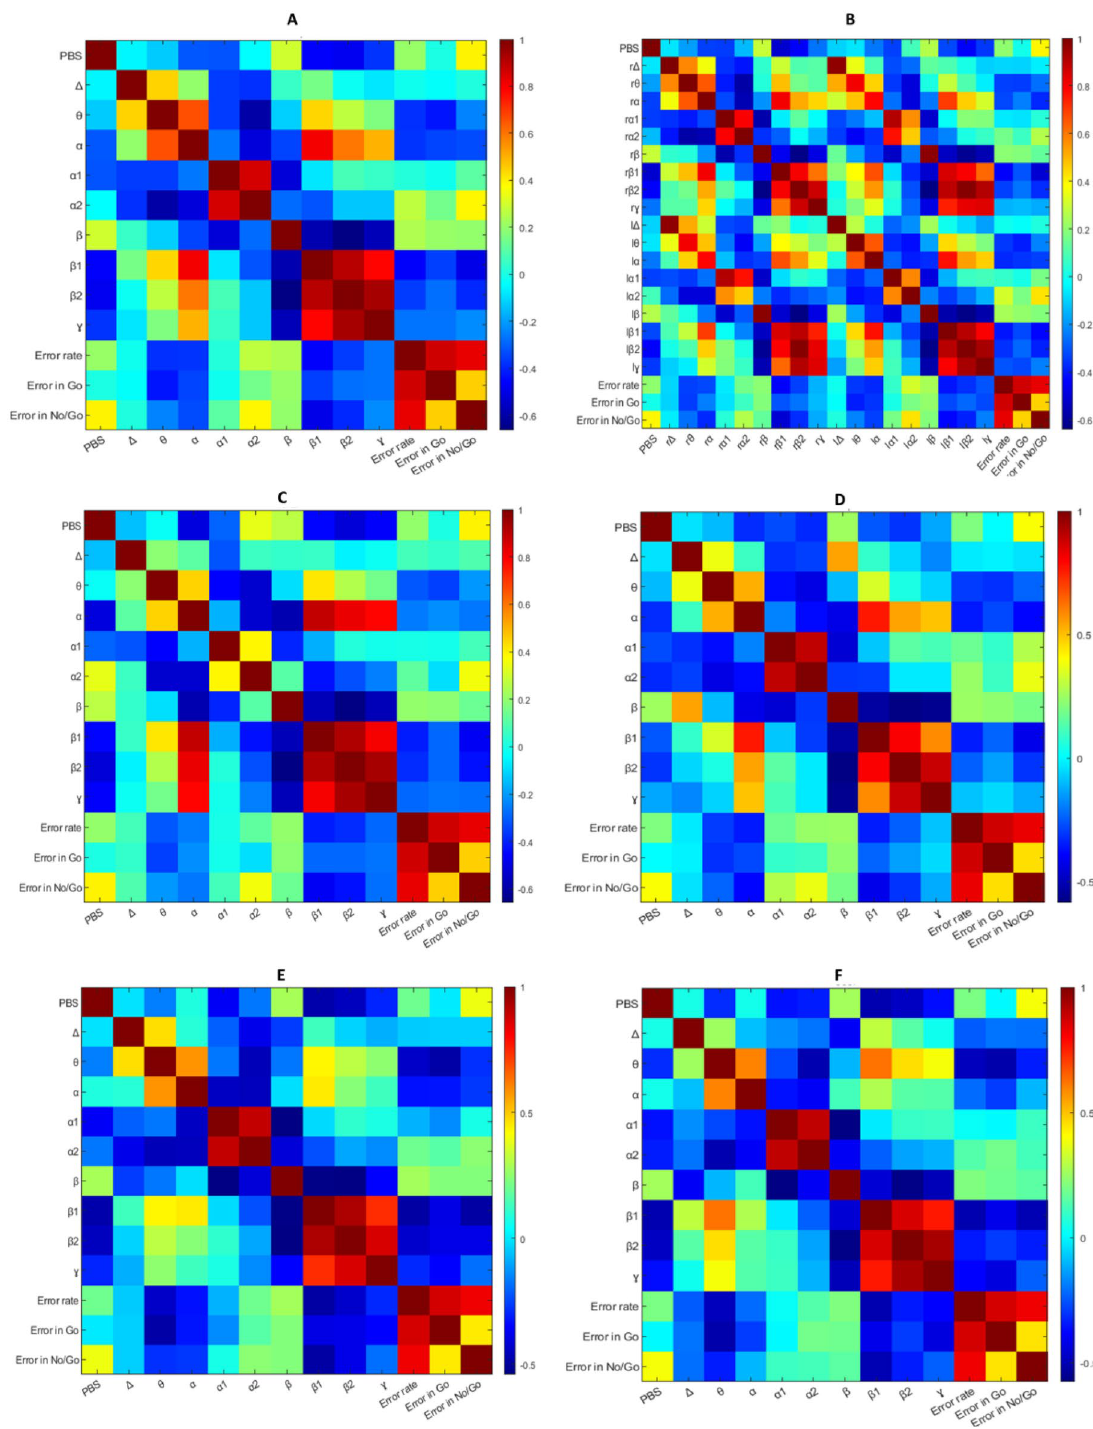
Figure 7. The heatmap results of pairwise correlation matrices of the frequency bands, RPBS, and Go-No/Go task in ( A ) whole brain, ( B ) right and left hemispheres ( C ) frontal lobe ( D ) temporal lobe ( E ) parietal lobe, and ( F ) occipital lobe. RPBS paranormal beliefs scale, Δ Delta band, θ Theta band, α Alpha band, α1 Alpha1 band, α2 Alpha2 band, β Beta band, β1 Beta1 band, β2 Beta2 band, ɣ Gamma band, r right hemisphere, l left